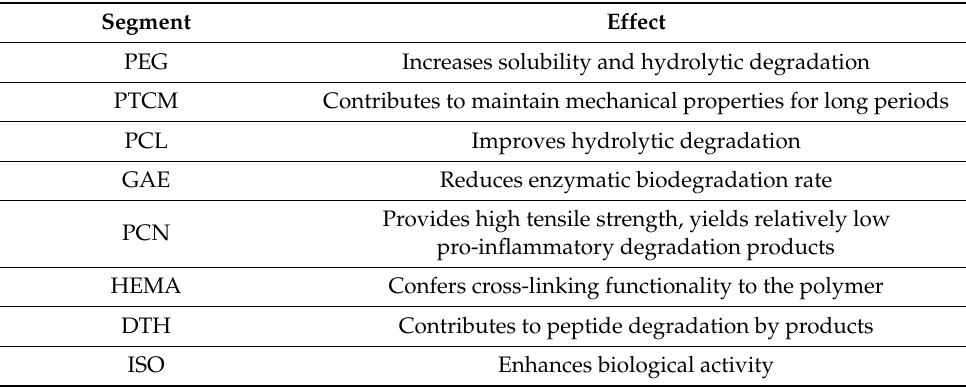
Table 3. Effect of different segments and chain extender on the properties of PU [56].